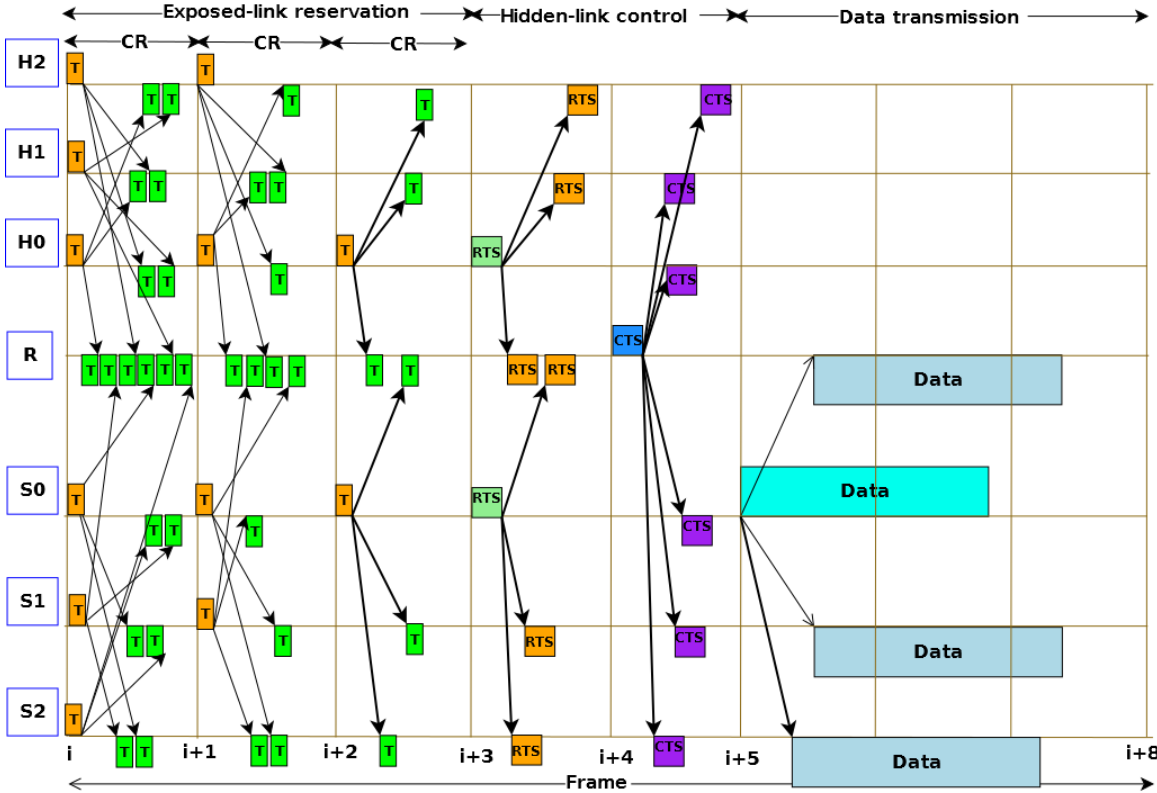
Figure 3. Medium access control (MAC) mechanism of the proposed